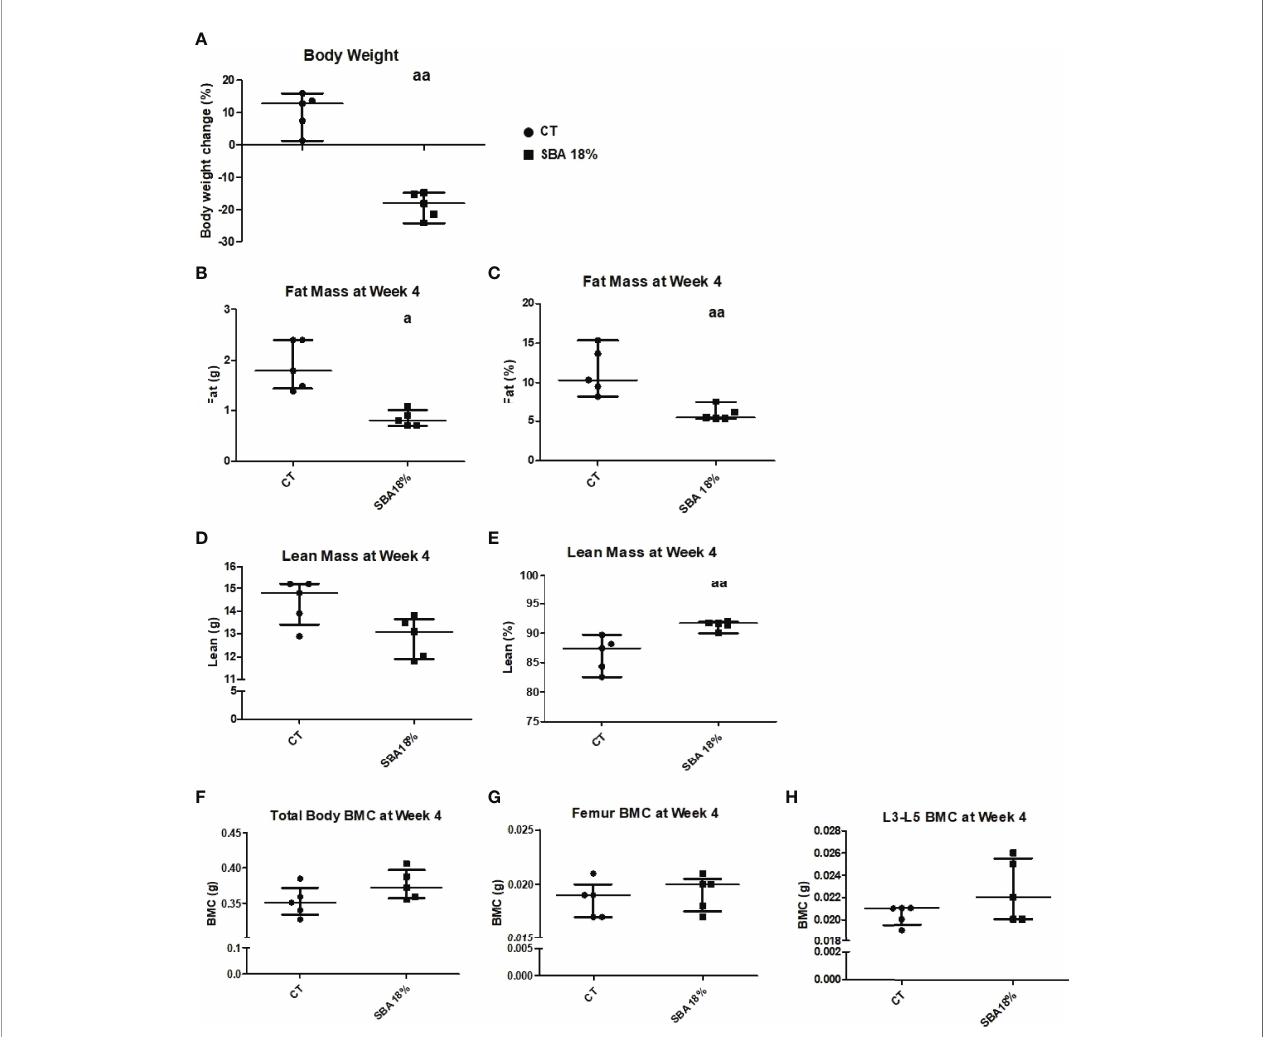
FIGURE 7 | Body mass, BMC, fat and lean mass in mice after 4 weeks of SBA protocol. The body weight and composition analysis were performed on standard condition (CT) and weight loss group (SBA 18%). (A) Graph represents a percentage body weight loss on mice between day 0 and 4 weeks of SBA protocol; (B, C) Fat mass content presented in grams and % of total mass, respectively was evaluated for each mouse and condition after 4 weeks of SBA protocol; (D, E) Lean mass content presented in grams and % of total mass, respectively was evaluated for each mouse and condition after 4 weeks of SBA protocol; (F-H) Study of total mouse body mineral content (BMC), femur BMC and vertebra (L3-L5) BMC, respectively, evaluated for each animal and each condition after 4 weeks of SBA protocol. Data represent median and interquartile range; n = 5. Statistical analysis was performed using Mann – Whitney ’ s test; a - p < 0.05, aa - p < 0.005, when compared to the CT